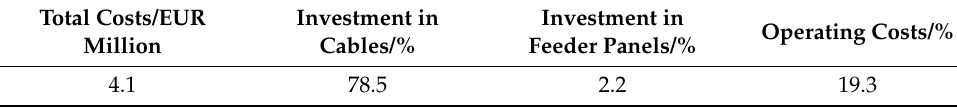
Figure 10. Line loading on the initially overloaded lines of the MV grid after optimizing the voltage setpoint of the HV/MV transformer and after grid expansion. Table 11. Results of the planning variant with underground